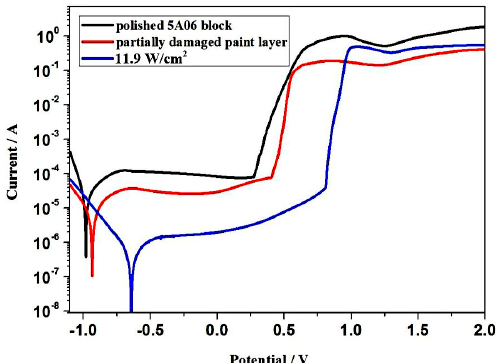
Figure 12. Tafel curves of the rust, bare and laser treated sample at different fluence in 3.5 wt % NaCl solution.